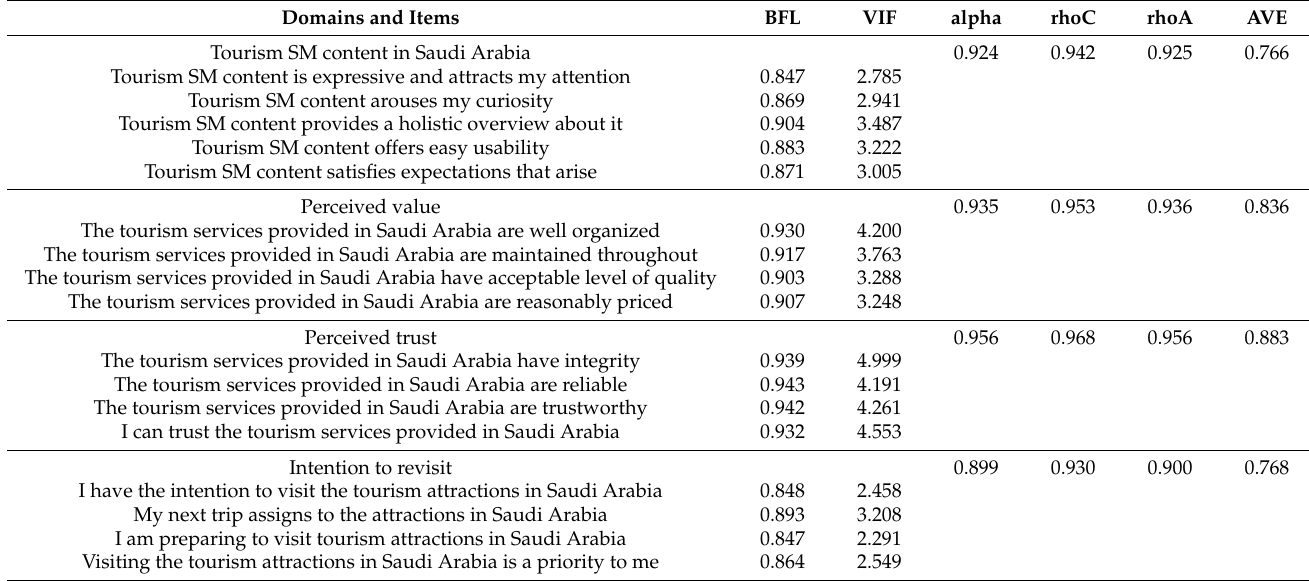
Table 2. Outcomes of the convergent validity and construct reliability. Domains and Items